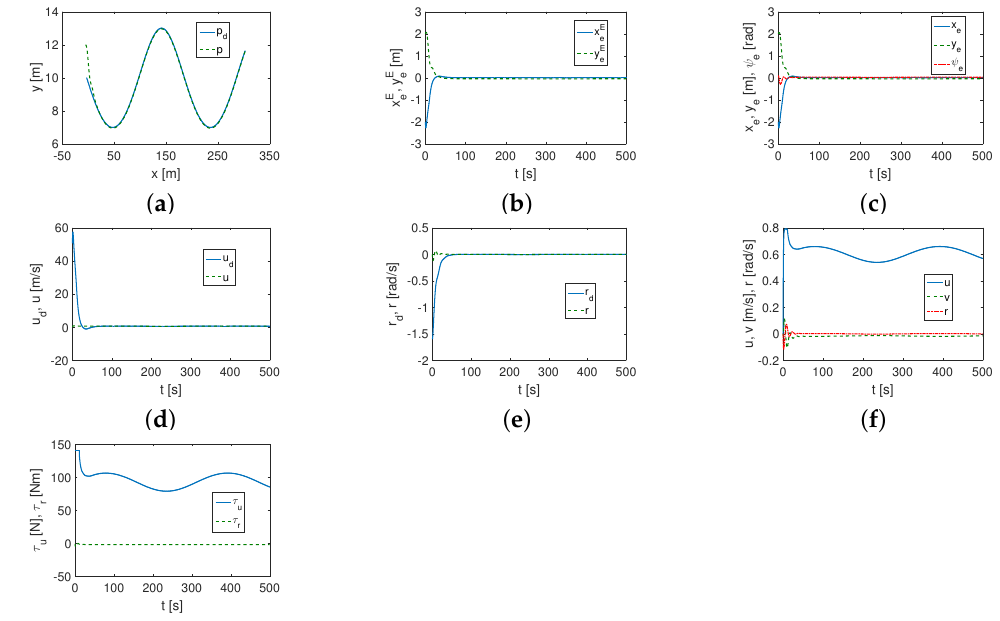
Figure 8. Simulation results for Kambara—IQV controller and cycloid trajectory (constant distur- bances): ( a ) desired and realized trajectory; ( b ) position errors (E-frame); ( c ) position errors (B-frame) and angular error; ( d ) desired and realized velocity ( u d , u ); ( e ) desired and realized velocity ( r d , r ); ( f ) realized velocities; ( g ) applied force and